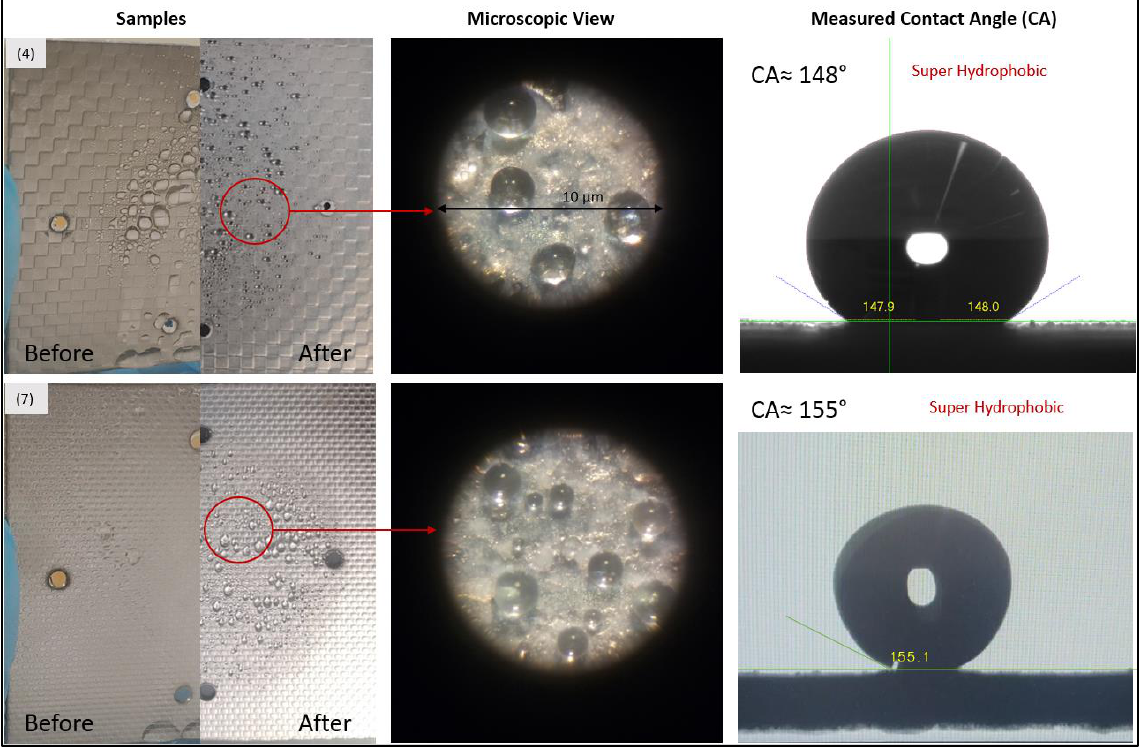
Figure 8: Samples showing photographs of the difference in the wetting of surface before/after applying the hydrophobic spray, droplets under microscope, and contact angle with 15 μ